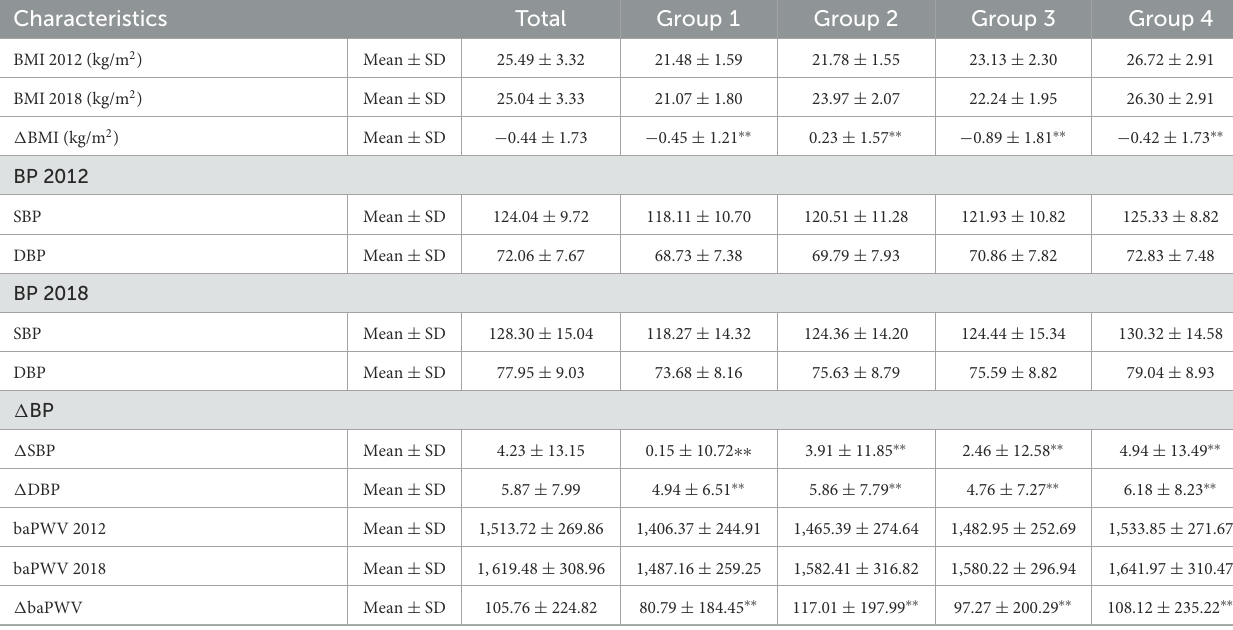
TABLE 4 Association of the 1 BMI, 1 SBP, 1 DBP, and 1 baPWV between baseline and follow-up with hypertension onset according to different obesity statuses.